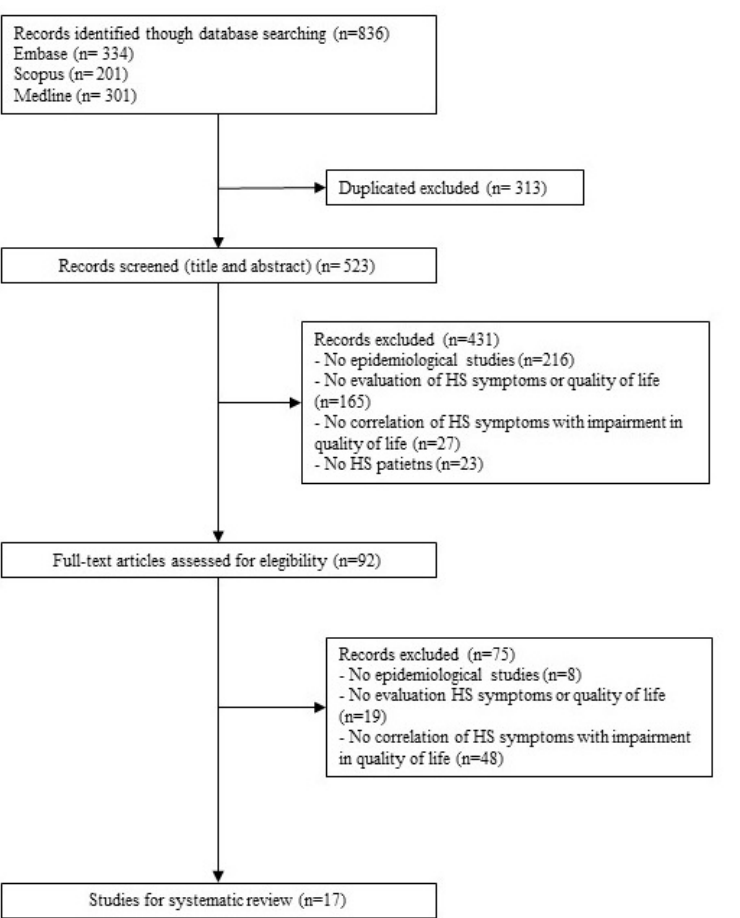
Figure 1. Flow chart of the studies included.